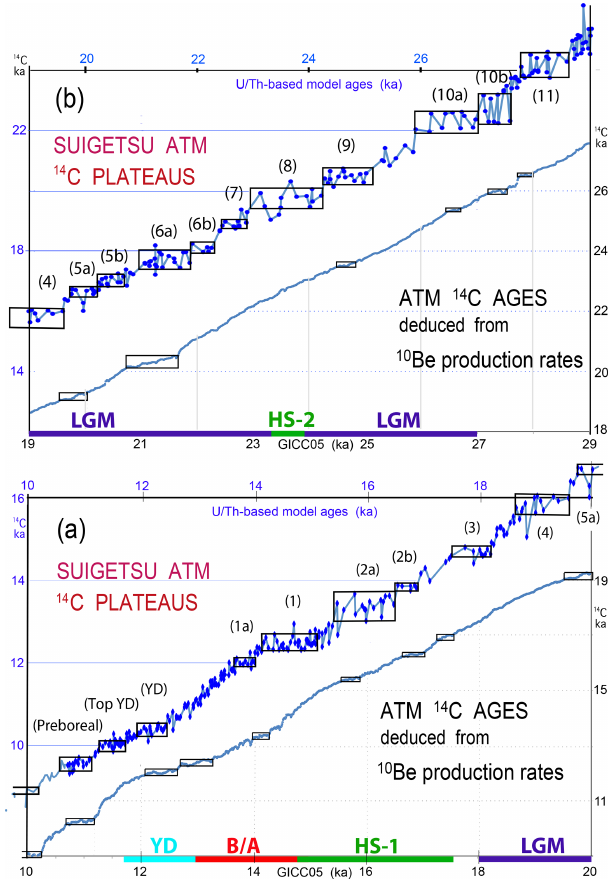
Figure 4. (a, b) Atmospheric 14 C ages and plateaus (horizon- tal boxes) deduced from 10 Be production rates vs. GICC05 age scale (Adolphi et al., 2018) compared to the Suigetsu record of atmospheric 14 C plateaus vs. Hulu Cave U / Th-based model ages (Southon et al., 2012; Cheng et al., 2018) for the intervals (a) 10– 20 and (b) 19–29calkaBP.